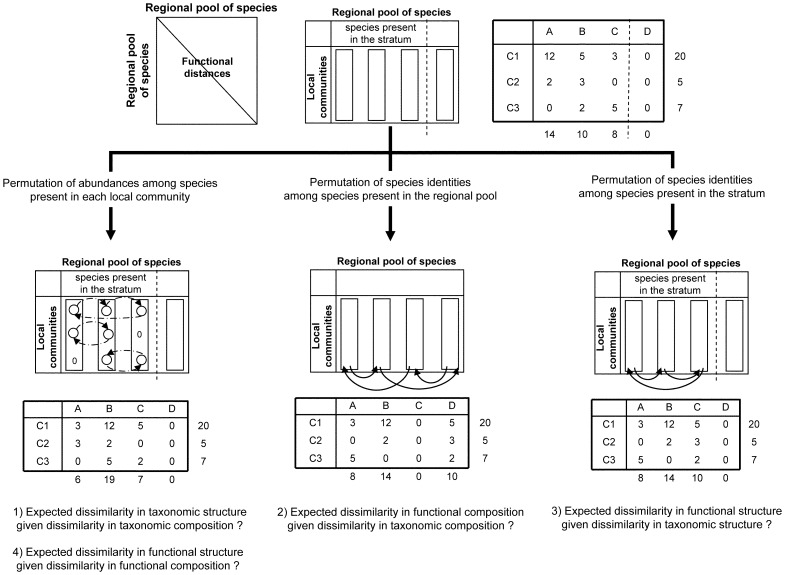
Schematic representation of the null-models used.Matrices of species abundances in set of communities (i.e. a stratum) and of pairwise functional distances are illustrated at the top. Note that species present at the stratum scale are a subset of the species present at the regional scale (i.e. global area of the study) and thus some columns of the abundance matrix contain only null values. A hypothetical example is provided on the top right, with the sum of columns (i.e. species abundances at the stratum scale) and lines (i.e. total abundances in local communities). The first procedure consists in shuffling abundances among the species present in each local community. This generates expected values of dissimilarity in taxonomic structure given the observed dissimilarity in taxonomic composition (null-model 1) as well as expected values of dissimilarity in functional structure given observed dissimilarity in functional composition (null-model 4). The second procedure randomly permutes columns of the abundance matrix at the regional scale to generate expected values of dissimilarity in functional composition without modifying the dissimilarity in taxonomic composition (null-model 2). The third procedure is similar but columns are permuted only among species present at the stratum scale so it produces the expected level of dissimilarity in functional structure without modifying dissimilarity in functional composition (null-model 3). None of the three permutation processes modifies the distribution of local abundances (i.e. contribution of the local communities to the total abundance of the stratum). For each procedure an illustration of output given the above example is provided.